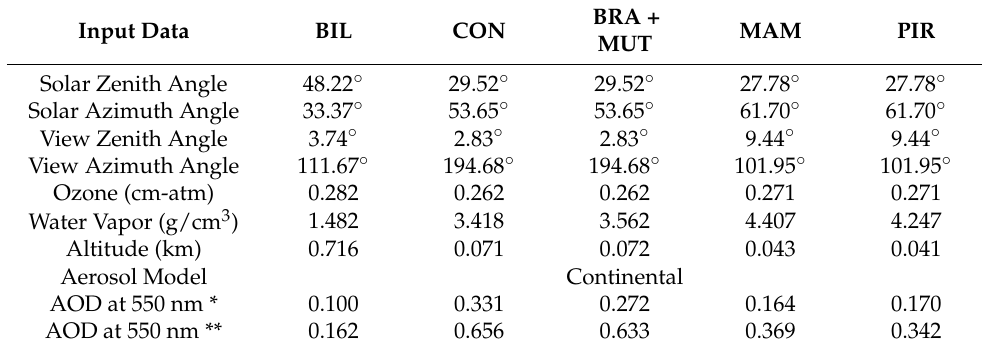
Table A1. Overview of input data required for the AC for water bodies included in this study.